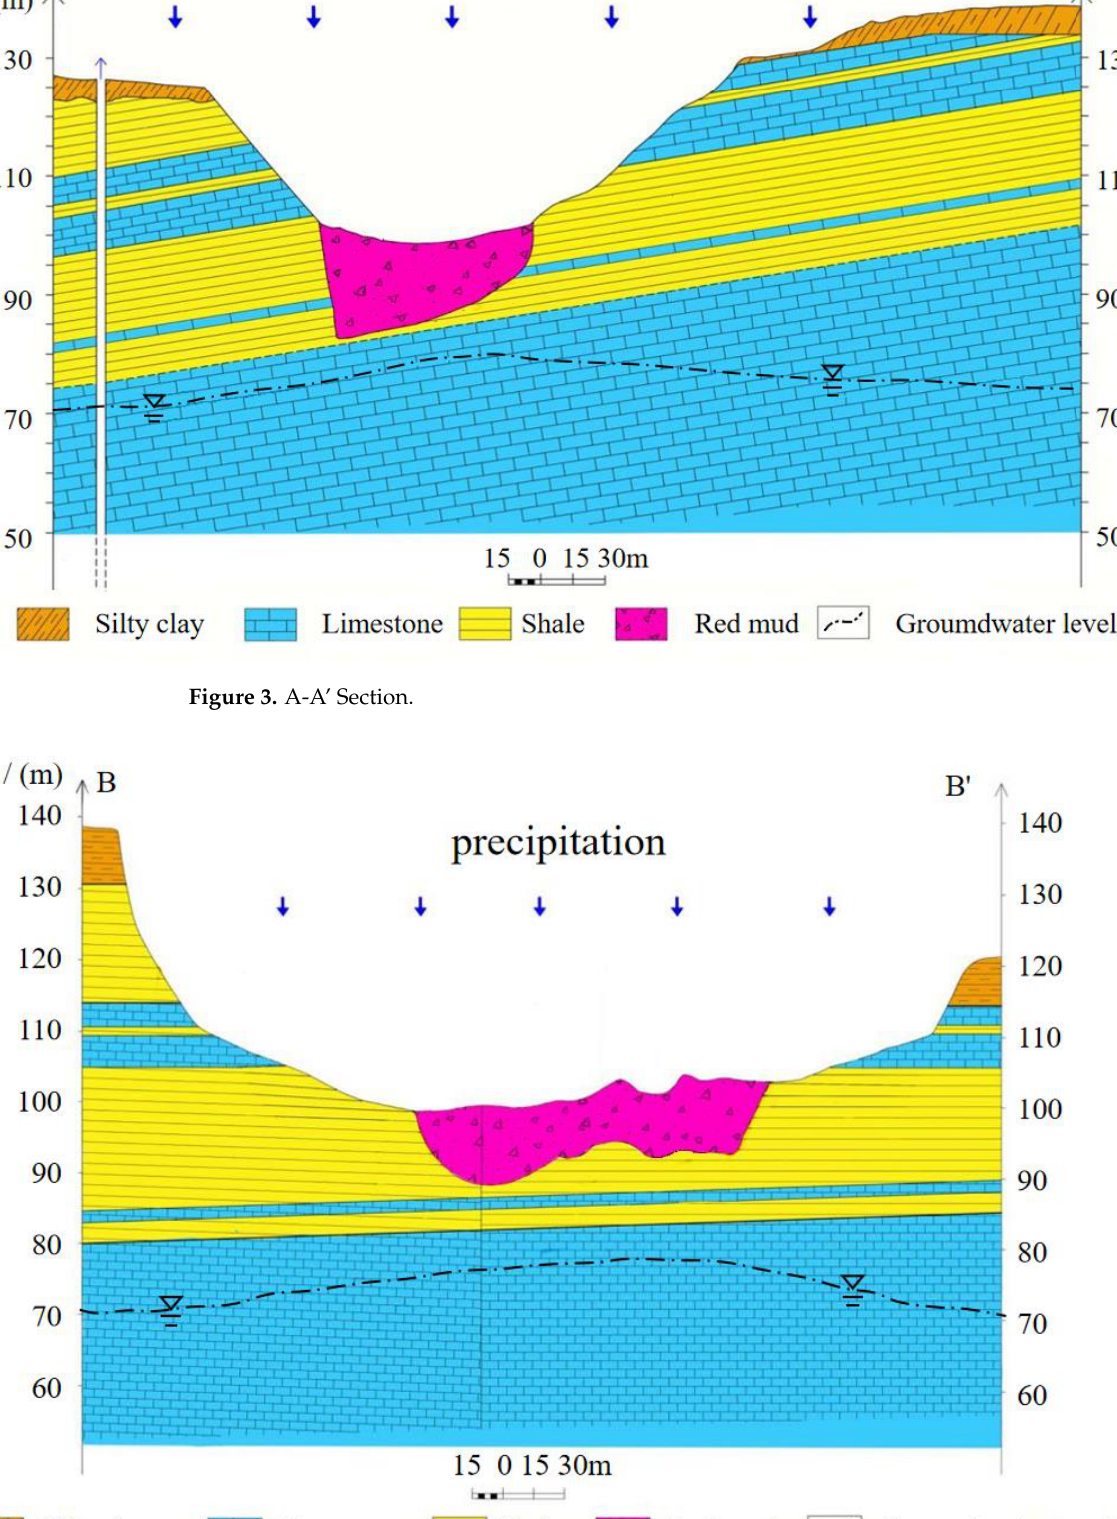
Figure 4. B- B’ section. ( the location of the sections was described in Figure 1).